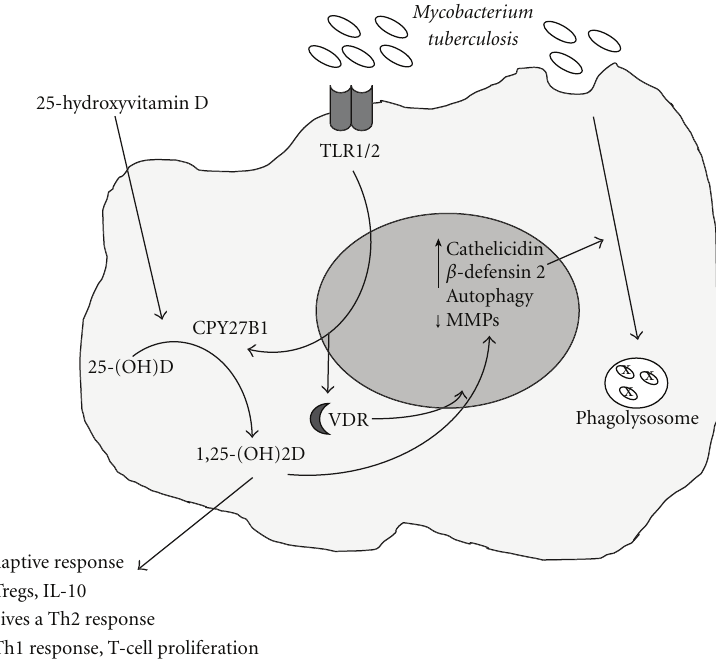
Figure 1: Mechanism of vitamin-D-induced immunity to Mycobacterium tuberculosis (modified from [16]). Stimulation of monocyte Toll- like receptors (TLR1/2) by Mycobacterium tuberculosis (MTB) results in transcriptional induction of the vitamin D receptor (VDR) and 1 α -hydroxylase (CYP27B1). Circulating 25-hydroxyvitamin D (25[OH]D) enters the cell and is converted to 1,25-dihydroxyvitamin D (1,25[OH]2D) by the CYP27B1 enzyme. VDR-bound 1,25(OH)2D then induces expression of cathelicidin and β -defensin 2 (DEFB4). In addition 1,25(OH)2D induces autophagy and downregulating metalloproteinases (MMPs), all of which help in the formation of phagolysosomes and the killing of Mtb. 1,25(OH)2D also a ff ects the adaptive immune system and leads to an upregulation of regulatory responses and a skewing towards a Th2 response. IFN γ is thought to induce the expression of the CYP27B1 enzyme suggesting a feedback mechanism between the innate and adaptive response to vitamin